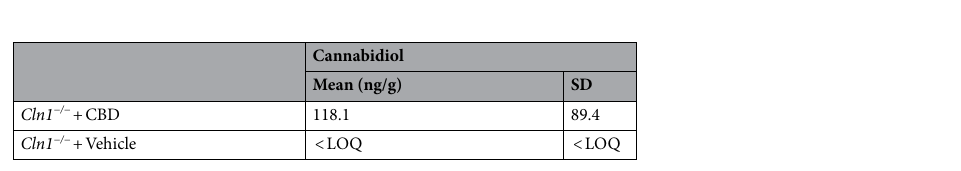
Table 2. Voluntary oral administration via gelatin cube delivers quantifiable levels of CBD to the brain. Limit of quantification (LOQ) was 1.5 ng/g